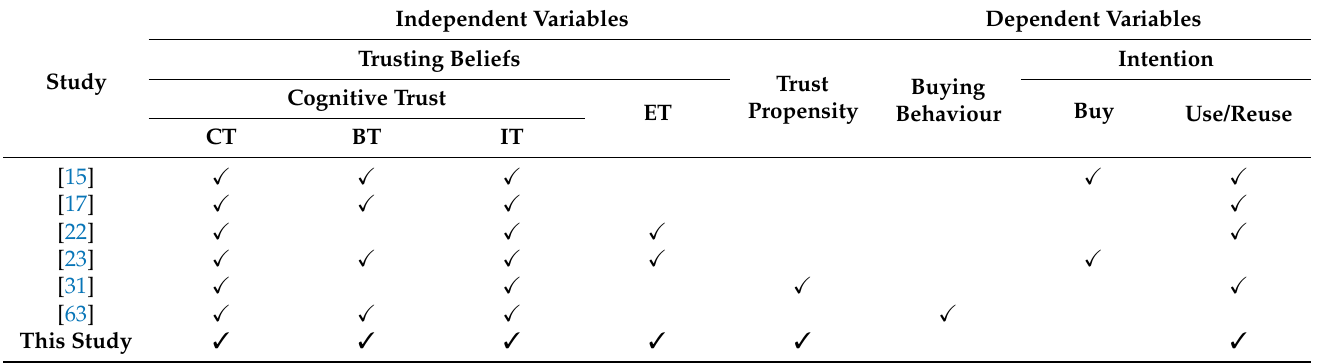
Table 1. RSs Studies focusing on the concept of “Trust” and its impact on buying behaviour, buying intention or use/reuse intention. Independent Variables Dependent Variables Trusting Beliefs Study Cognitive